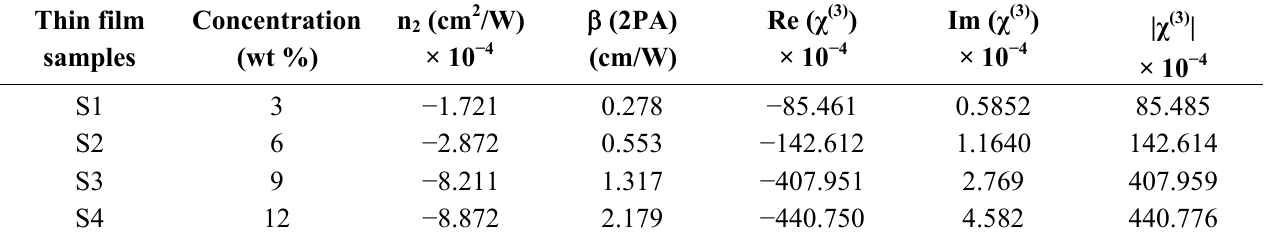
Table 1. The nonlinear optical parameters measured for PPy/MWNT at different concentrations. Thin film samples